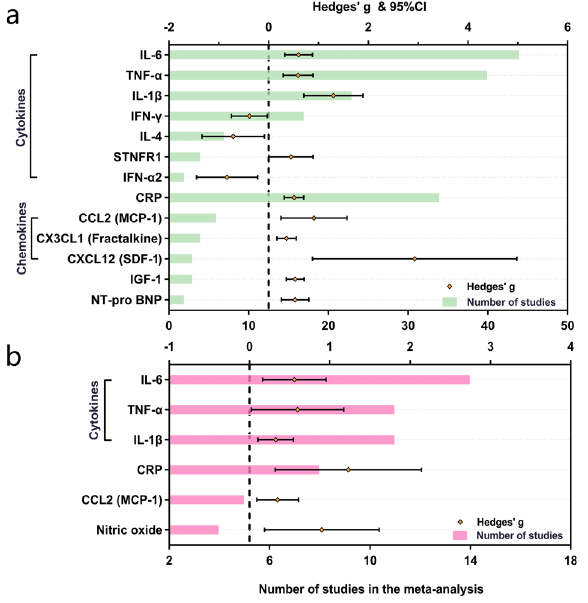
Fig. 2 Comparative outcomes of peripheral blood and cerebrosp- inal fl uid biomarkers in the meta-analysis. The peripheral blood ( a ) and cerebrospinal fl uid ( b ) in fl ammatory markers with signi fi cant effect sizes (Hedges ’ g) were displayed in comparisons for PD patients versus controls. Orange spots indicate Hedges ’ g of each marker, and green and pink bars indicate the number of studies included. CCL chemokine (C-C motif) ligand, CRP C-reactive protein, CX3CL CX3 chemokine ligand, CXCL chemokine (C-X-C motif) ligand, IFN Interferon, IL interleukin, MCP monocyte chemoattrac- tant protein, NT-pro BNP N-terminal pro-B-type natriuretic peptide, PD Parkinson ’ s disease, SDF stromal cell-derived factor, STNFR soluble tumour necrosis factor receptor, TNF tumour necrosis factor.